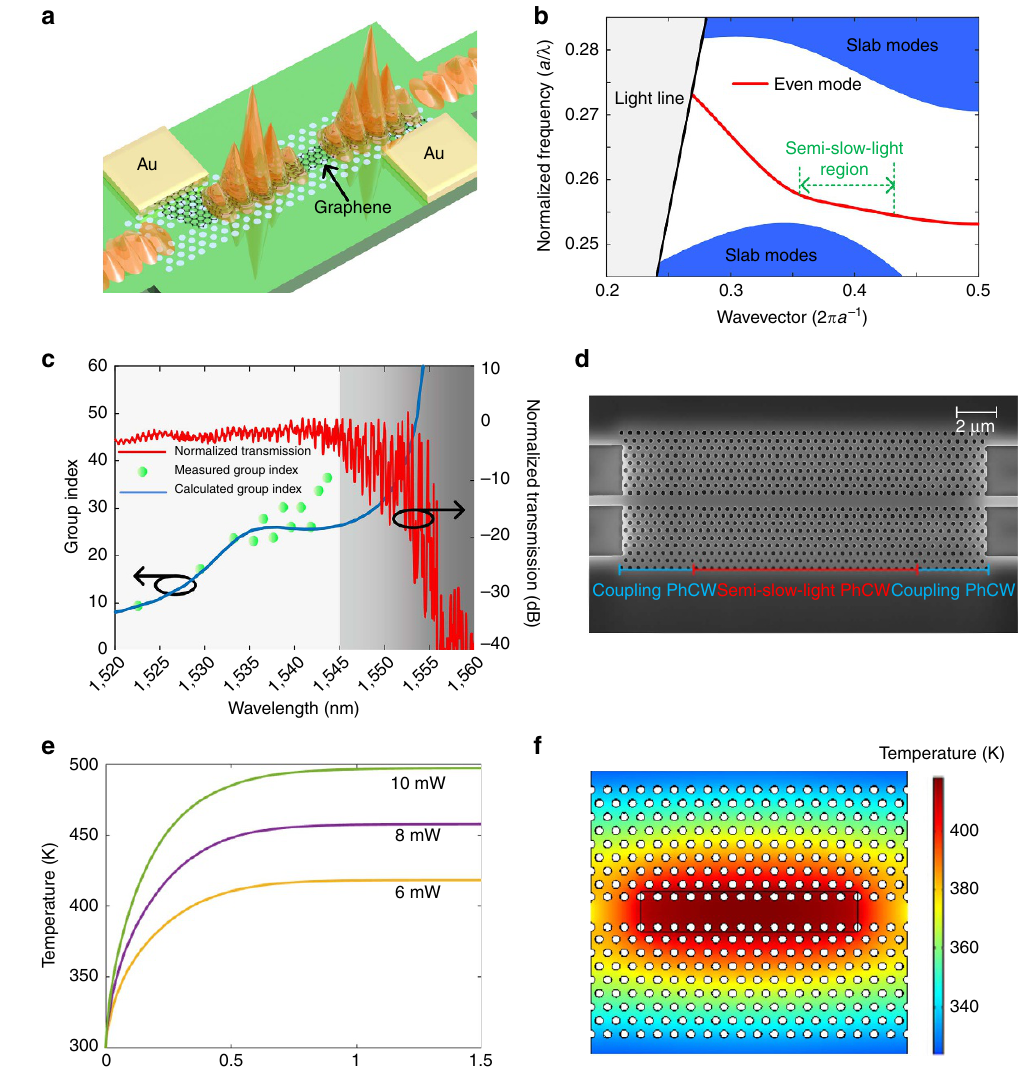
Figure 1 | Design and theoretical calculation of a slow-light-enhanced graphene microheater. ( a ) Schematic of the slow-light-enhanced graphene heater. ( b ) Band structure of the photonic crystal waveguide. The even guiding mode (red curve) consists of a semi-slow-light region (green dashed line). The blue-shaded area indicates the slab modes. ( c ) Calculated group index (blue curve), measured group index (green dots) and the transmission spectrum (red curve) of the photonic crystal waveguide. The grey-shaded area indicates the bandgap area of the PhCW. ( d ) The scanning electron microscope image of the fabricated photonic crystal waveguide. ( e ) The temperature response for different heating power. ( f ) The temperature distribution of a graphene– PhCW